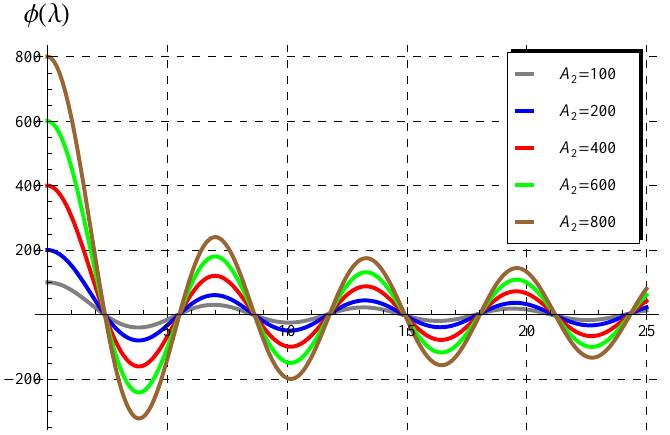
Figure 4. Behavior of φ ( λ ) vs. λ in the range 50 ≤ A 2 < 100.